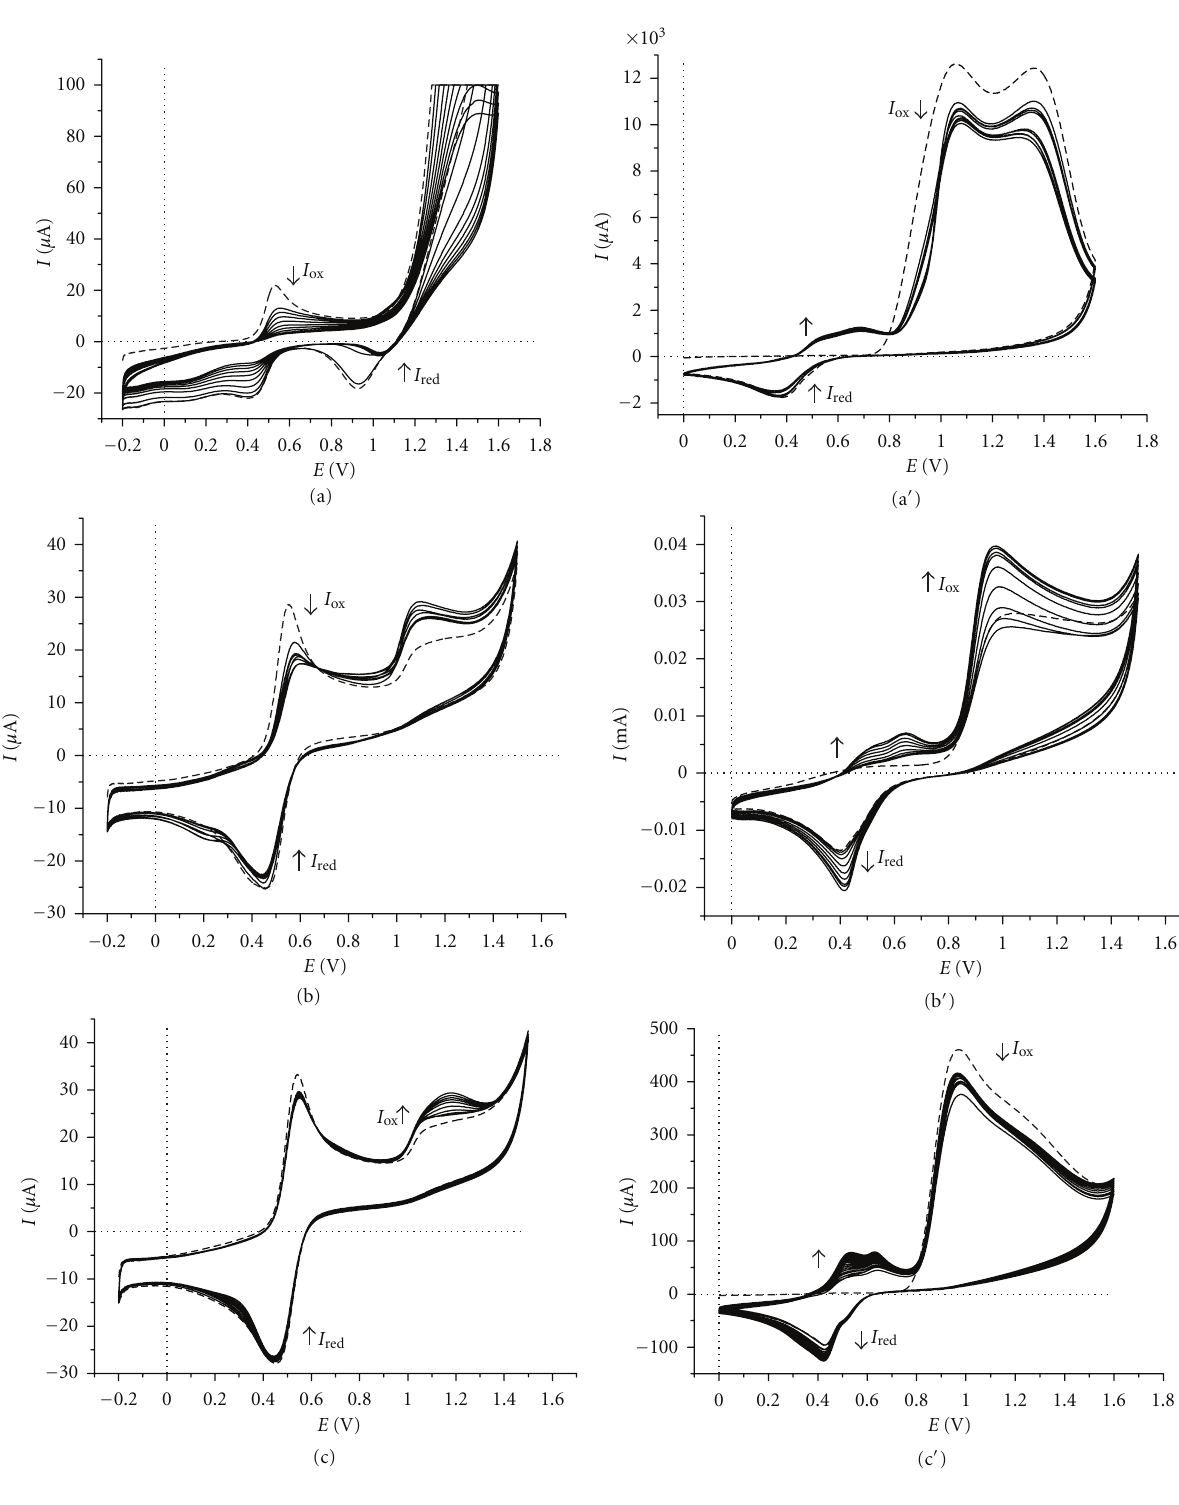
Figure 5: Multicyclic voltammograms (20 cycles) of 1.0 mM DAnPS in (a) DMF-HCl (1M), (b) DMF-H 2 SO 4 (1M) and (c) DMF-HClO 4 (1M), and 1.0 mM AnPS at Pt electrode (disk shape,1.6 mm diameter) in (a (cid:3) ) HCl (1M), (b (cid:3) ) H 2 SO 4 (1M) and (c (cid:3) ) HClO 4 (1M); the dotted line represents the first cycle. Scan rate: 50mVs − 1